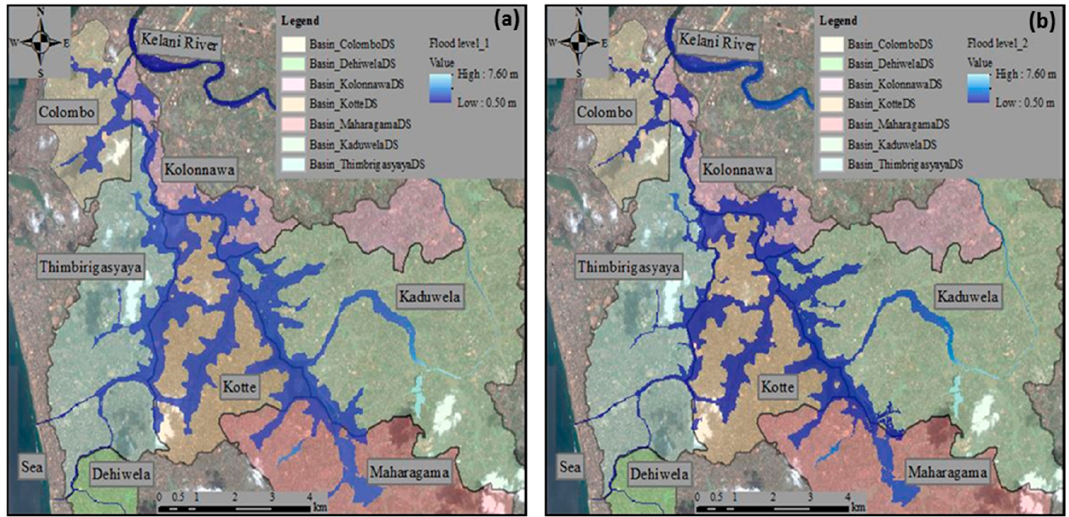
Figure 10. Inundation distributions for the model: ( a ) calibration; ( b ) validation events.